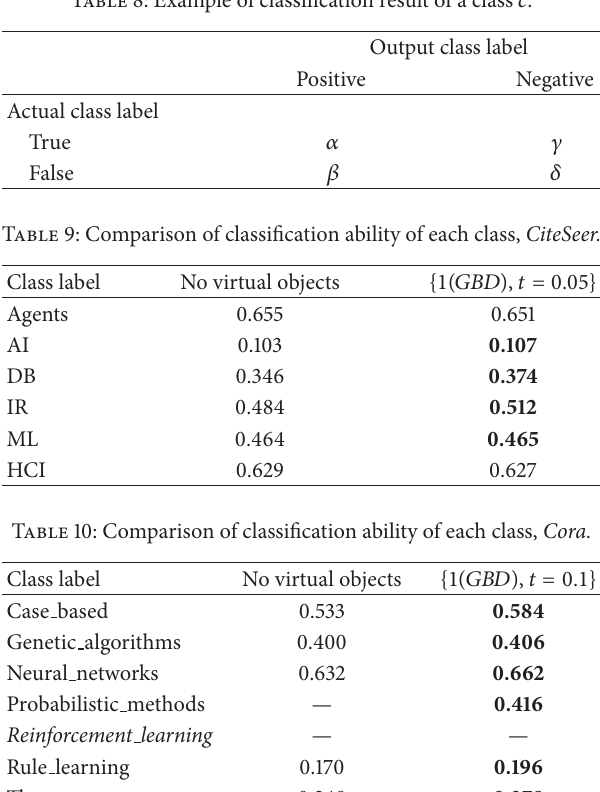
Table 8: Example of classification result of a class 𝑐 .